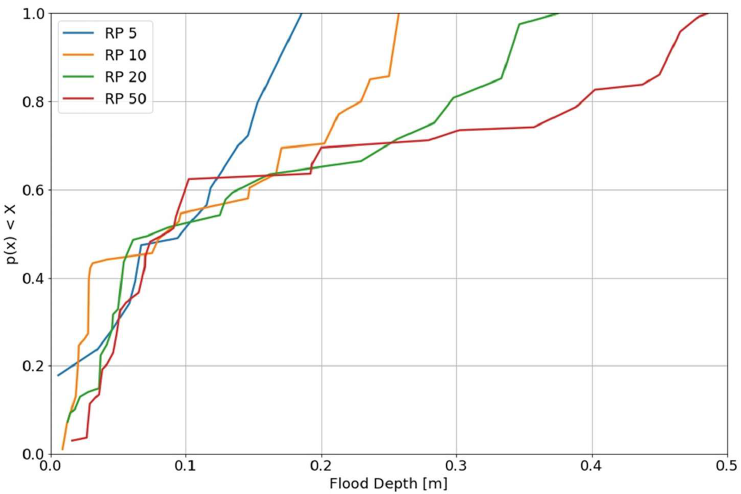
Figure 6. Cumulative distributions of flooded depths for four rainfall scenarios (5-, 10-, 20-, and 50-year return period synthetic rain events).